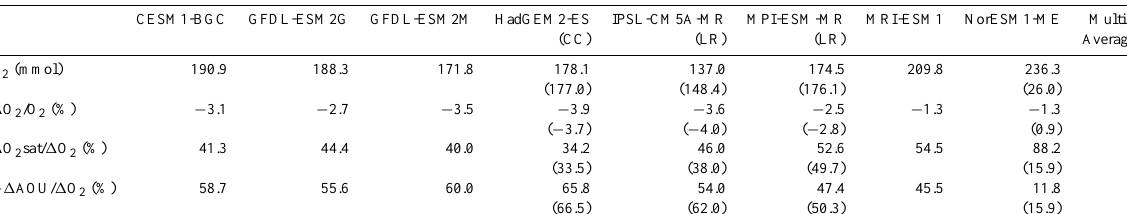
Table 1. Long-term trends in global oxygen and contribution from O 2 sat and AOU across CMIP5 models (columns). The first row shows global oxygen during the historical period 1960–1999, the second row shows relative change over 100 years from 1960–1999 to 2060–2099 (in %), and the third and fourth rows show the percentage of oxygen decrease due to a decrease in O 2 sat and an increase in AOU. The last column shows the multi-model average and standard deviation (SD) by weighting models as described in Table A1.